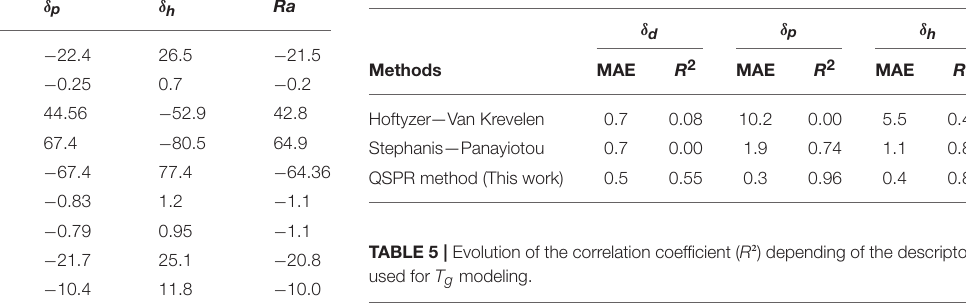
TABLE 4 | Comparison of the MAE and correlation coefficient R ² for the three methods of HSP prediction.